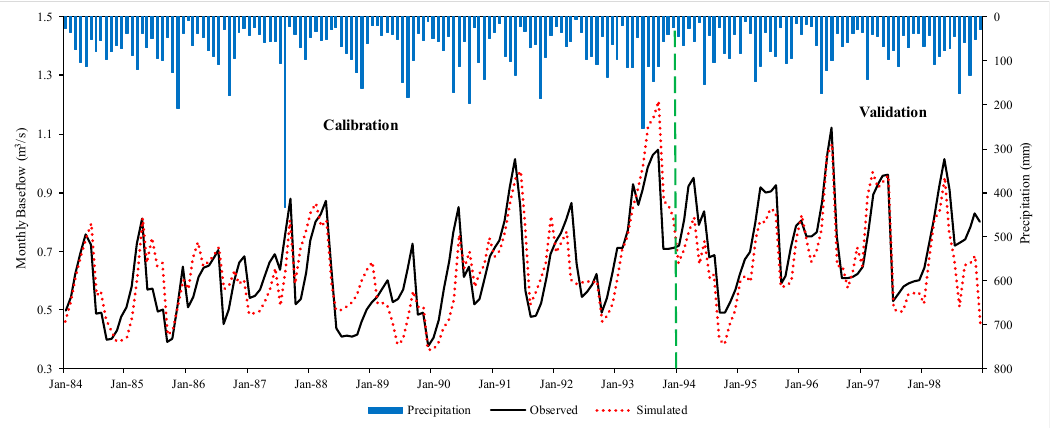
Figure 8. Observed and simulated time series baseflow for the UWBDR watershed during calibration and validation periods.